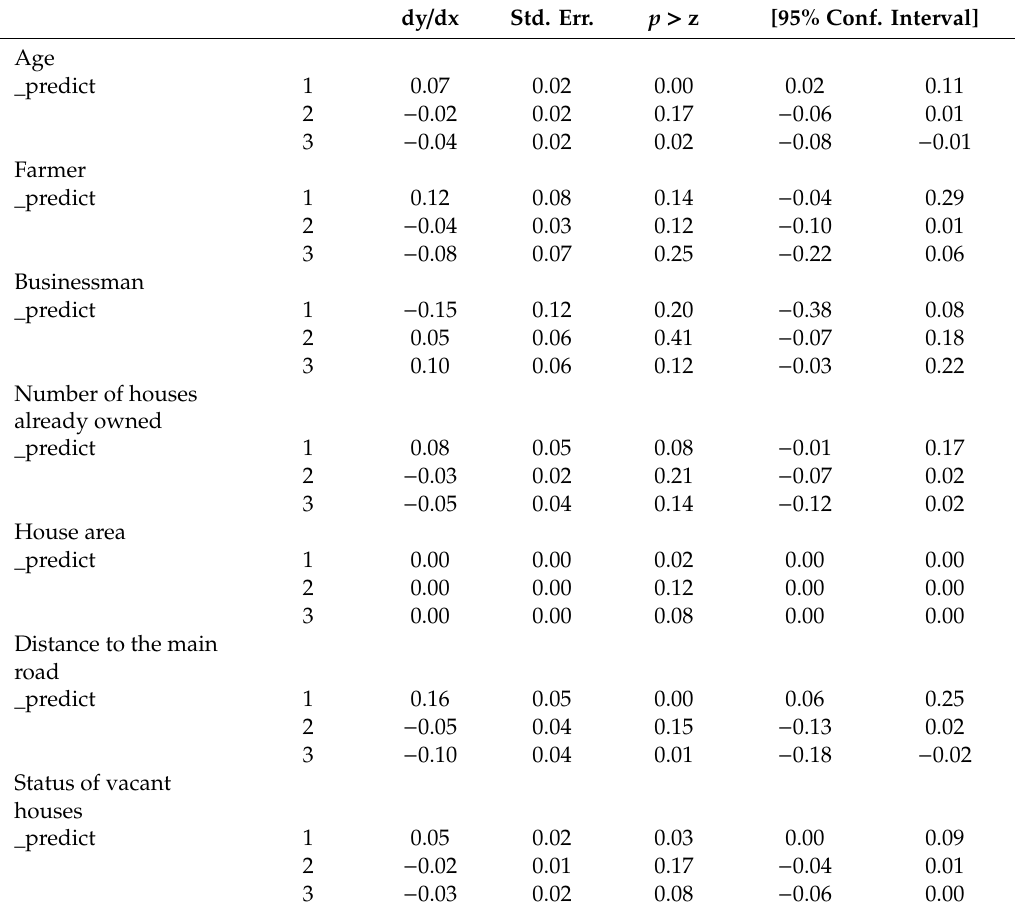
Table 9. Marginal e ff ects of main a ff ecting factors for house